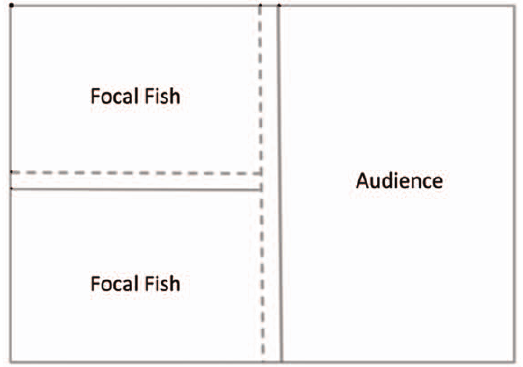
Figure 1. Experimental aquarium setup. Looking into the aquarium from directly above, focal fish would be in smaller adjacent compartments (equipped with a flowerpot shelter – not shown) while the audience would be in the larger compartment. Solid lines represent removable opaque barriers and dashed lines are permanent clear barriers, making the compartments water tight.